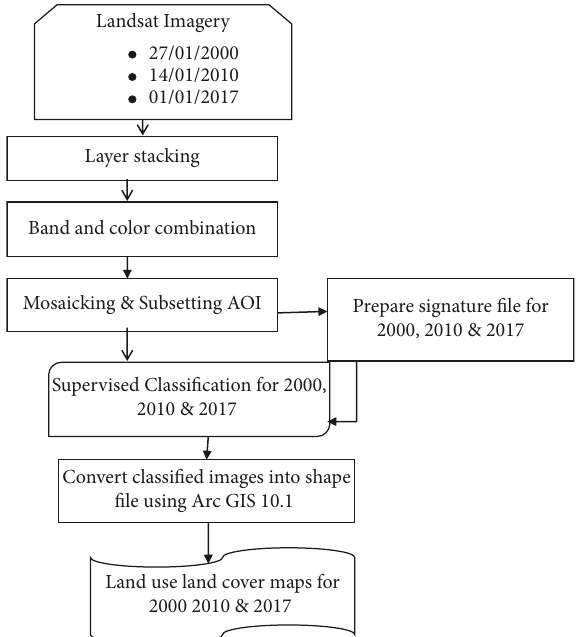
Figure 2: Flow chart for land use/cover classification